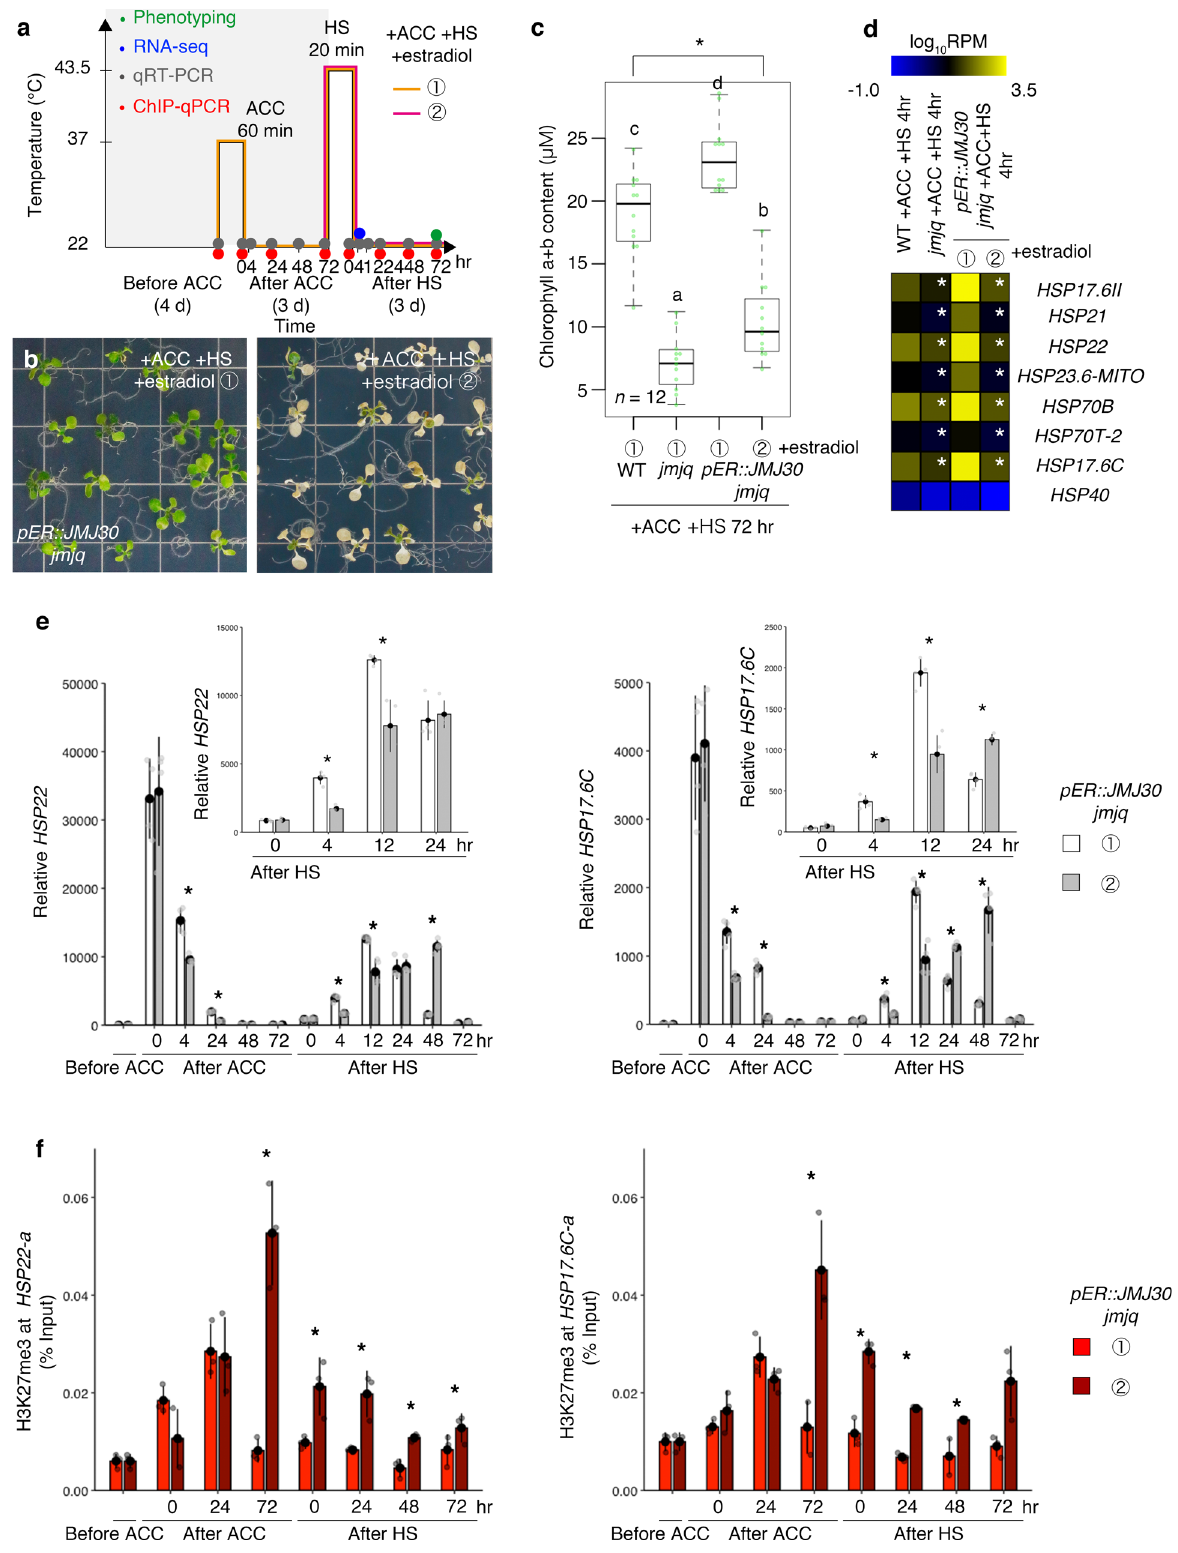
all reduced in jmjq mutants grown under the Nara temperature conditions, similar to mutants grown under the standard laboratory conditions. By contrast, all fi ve genes were signi fi - cantly induced when JMJ30 expression was induced in the mutant before ACC (Fig. 5d, e, Supplementary Fig. 31, and Supplementary Data 10 –